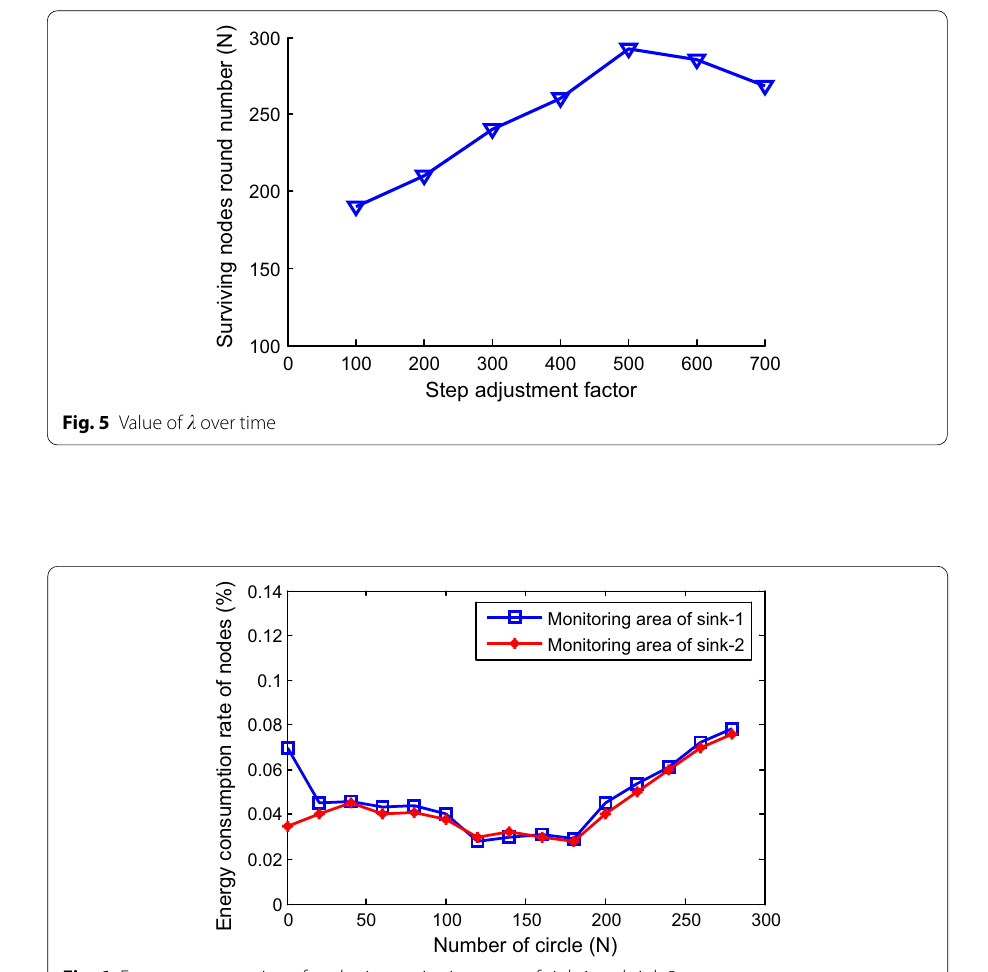
Fig. 6 Energy consumption of nodes in monitoring areas of sink-1 and